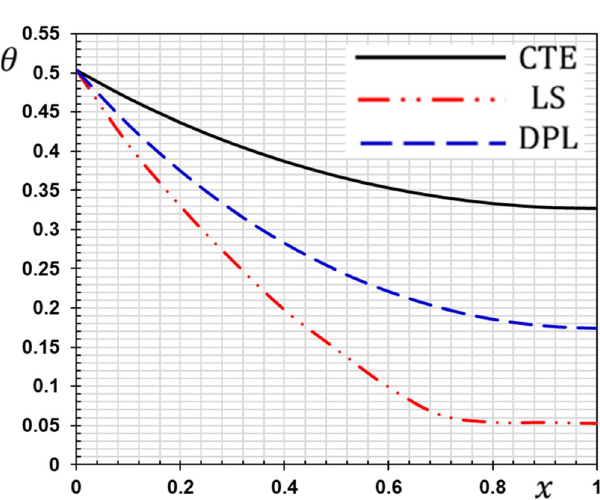
Figure 11. The temperature with different thermoelastic